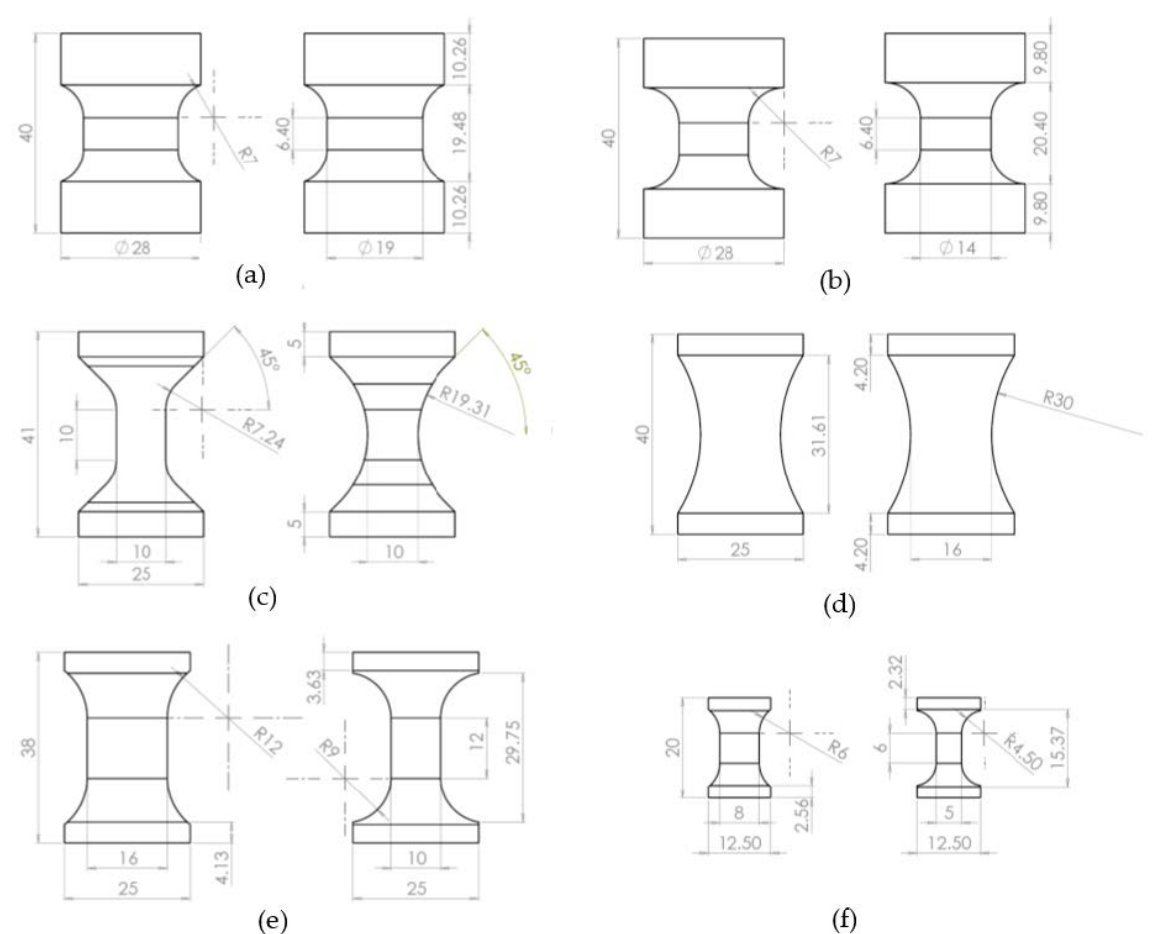
Figure 2. Engineering drawings of direct geometries. ( a ) Spool A, ( b ) spool B, ( c ) bi-lateral waist, ( d ) RARDE Type II, ( e ) RARDE Type III, and ( f ) RARDE Type III